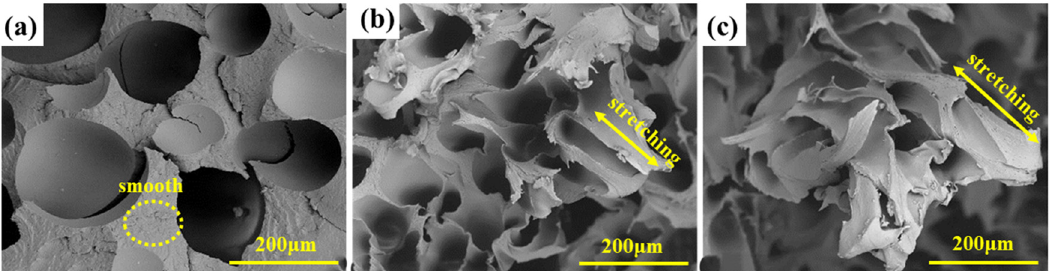
Figure A3: Tensile fracture surfaces of ( a ) pure PA6, ( b ) PA6 - ZeMac 0.5, and ( c ) PA6 - TGIC 0.5.